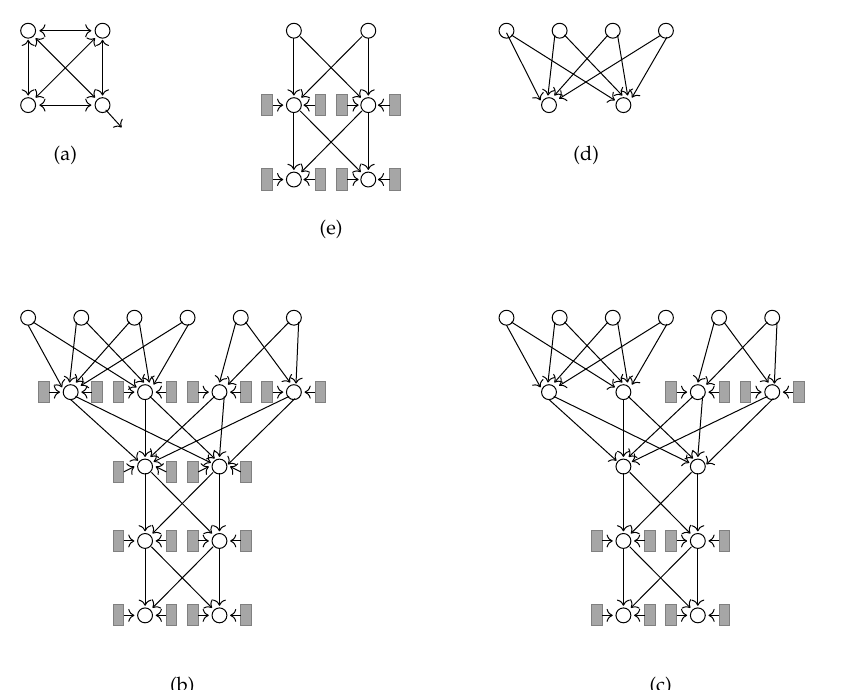
Figure 3. ( a ) A stable clique. ( b ) A ( 3,2 ) -selector. ( c ) A ( 3,1 ) -reverse selector. ( d ) A ( 2,0 ) -reverse selector. ( e ) A ( 1,2 ) -selector (or, equivalently, a ( 1,2 ) -reverse